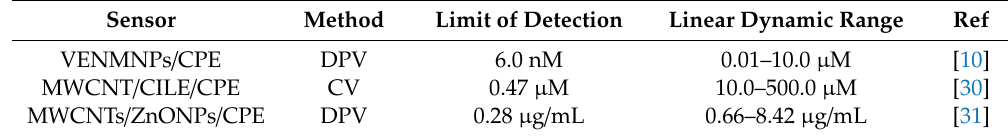
Table 1. Many characteristics of the carbon paste electrodes (CPE) in venlafaxine (VEN) electrochemical